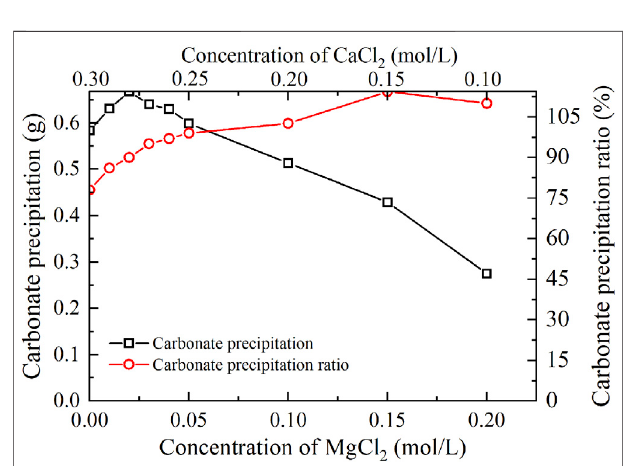
FIGURE 5 | Relations of the actual mass of carbonate precipitation and the precipitation ratio (PR) versus the MgCl 2 concentration in the modi fi ed EICP